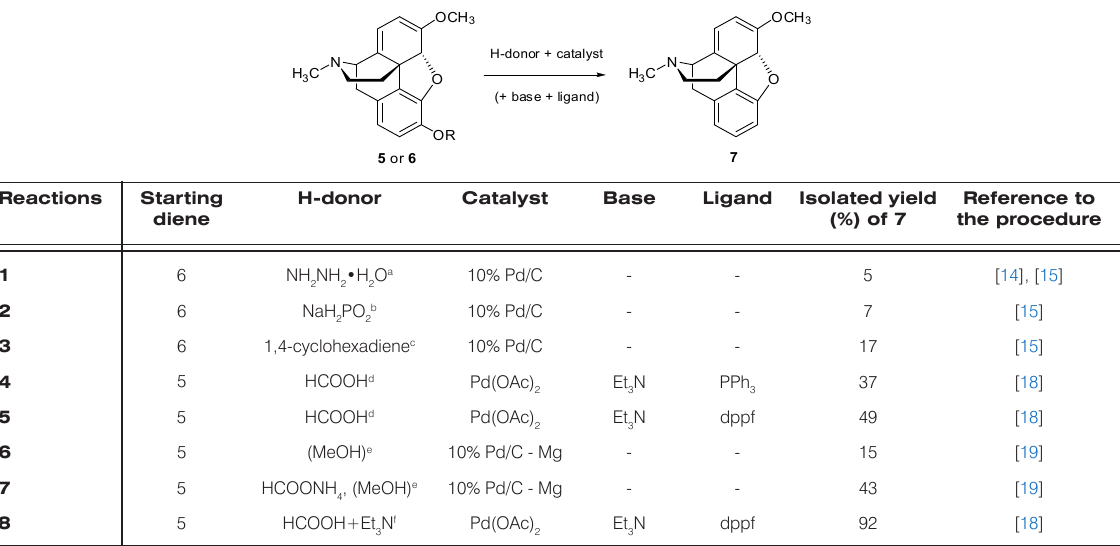
Table 1. Results of the hydrogenolysis reactions aimed at 3-deoxyoripavine (7)